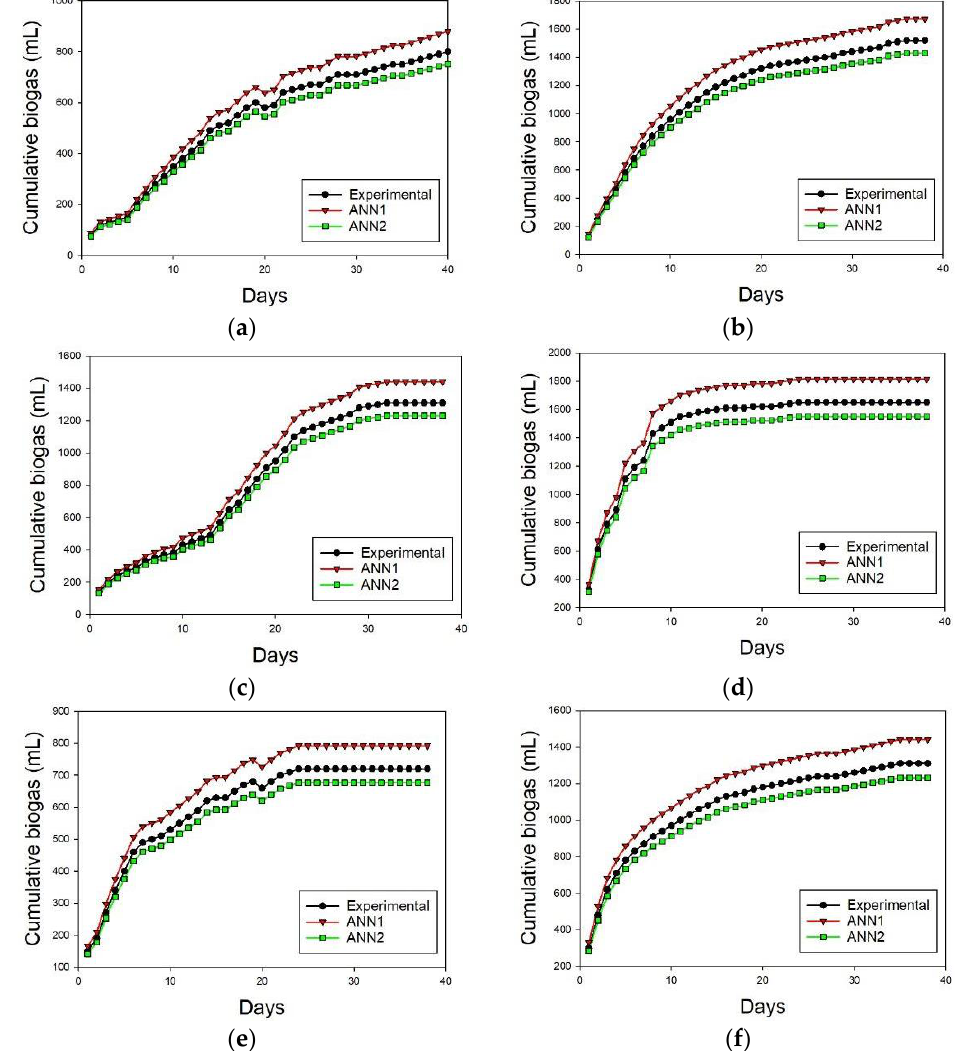
Figure 12. ANN graph fitting for CM, MR, and CM + MR: ( a ) CM WoF, ( b ) CM WF, ( c ) MR WoF, ( d ) MR WF, ( e ) CM + MR WoF, ( f ) CM + MR WF.